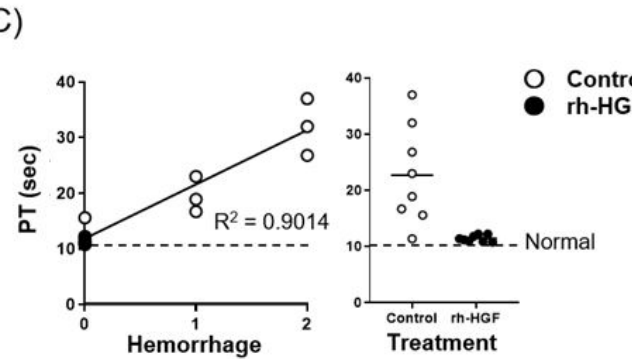
Figure 4. Correlation between the degree of hemorrhage and blood parameters. Correlation analysis between the degree of hemorrhage and ( A ) AST, ( B ) ALT, and ( C ) PT were conducted, and their resulting contribution values (R 2 ) were shown in the left panels. Distributions of each blood parameter were presented according to the treatment (right panels). Average PT (10.6 s) in normal mice was indicated with a dotted line in ( C ). Control (PBS, open circles) or rh-HGF (1.5 mg / kg, closed circles) was administered to the